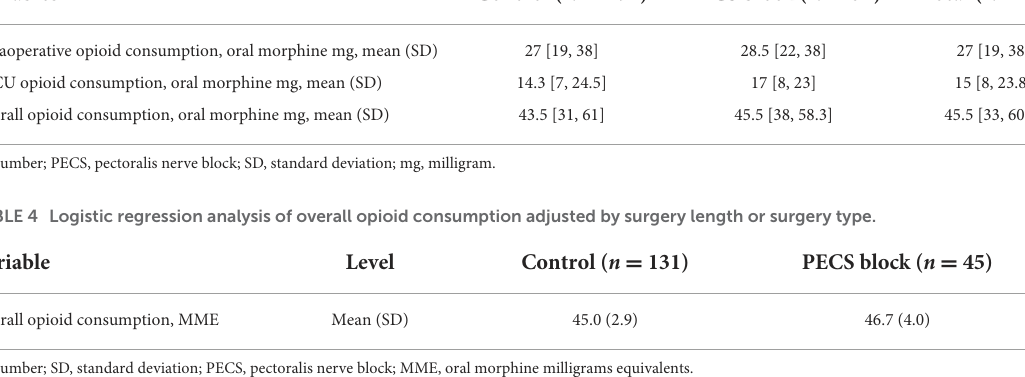
TABLE 3 Perioperative opioid consumption. Variables